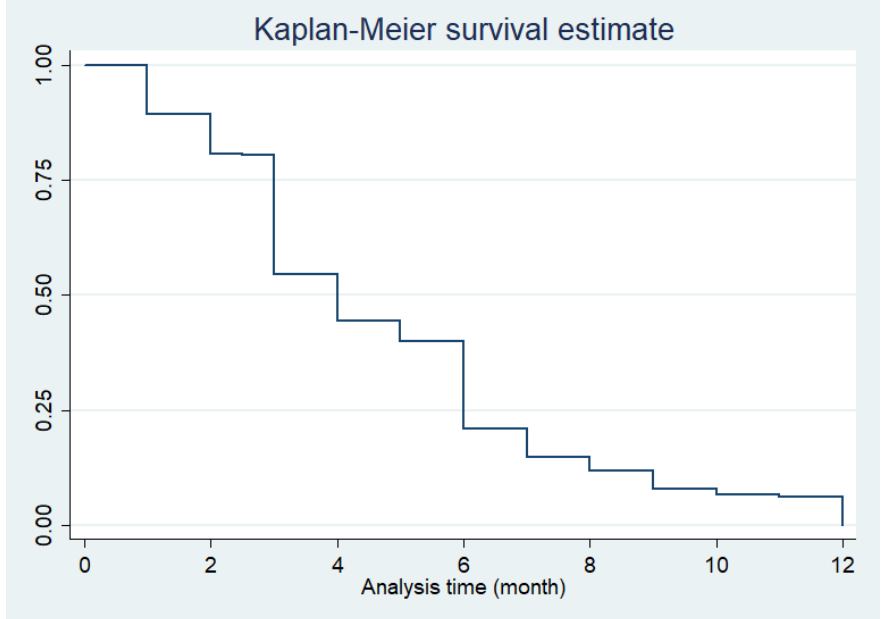
Figure 5. Six-month exclusive breastfeeding survival analysis (months) .